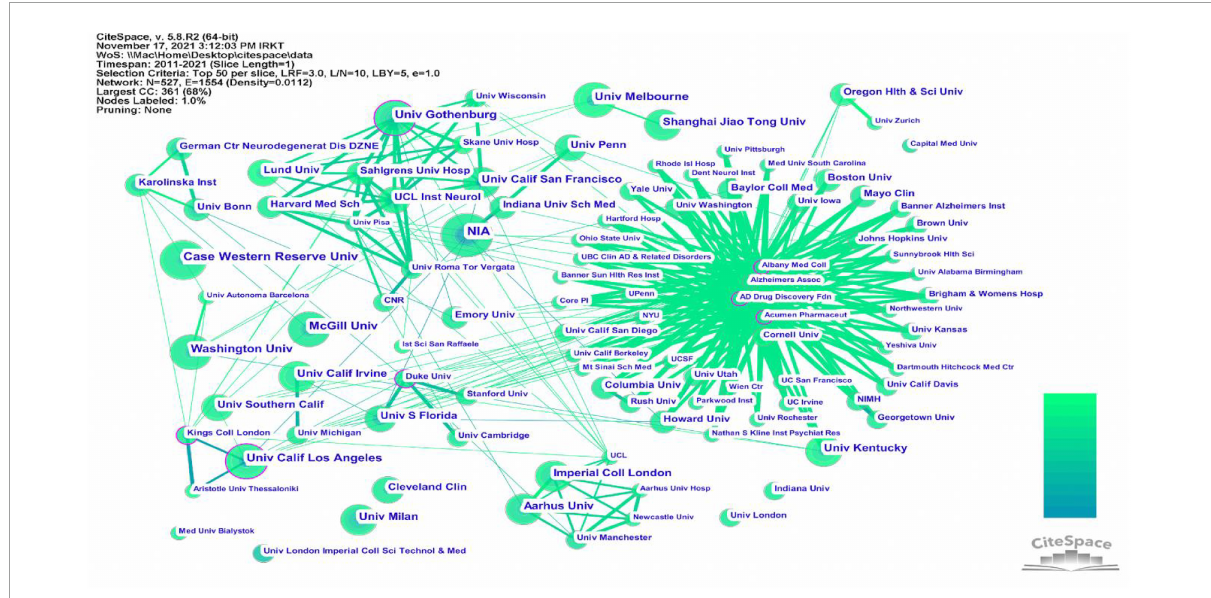
FIGURE6 The cooperation network visualizations map of institutions created using CiteSpace. Node and line size represent the number of publications from an institution and the cooperative relationship in the institution, respectively. Color represents a single time slice. The diameter of the purple outer ring represents the size of the centrality.